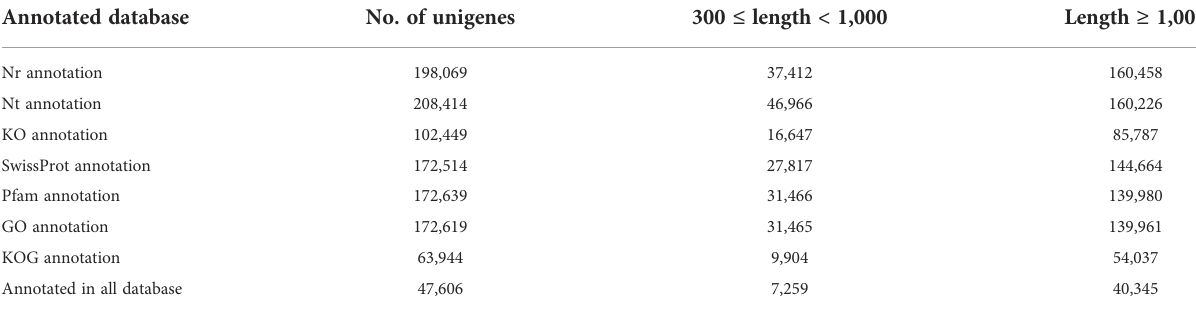
TABLE 5 BLAST analysis of the non-redundant unigenes against public databases.